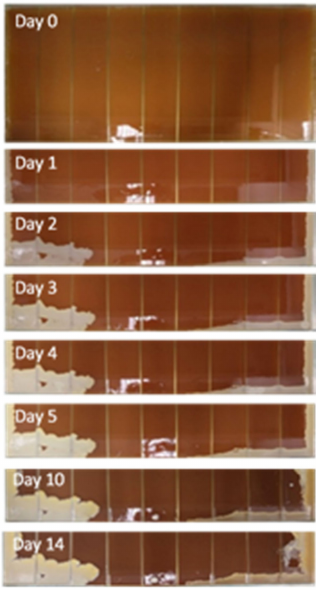
Figure 6. Photographic record of one of the MEGA-plate’s assays, in which it is possible to assess the multiplication through time and space of S. aureus ATCC 29213 on the left side of the plate and of S. aureus Z25.2 on the right side of the